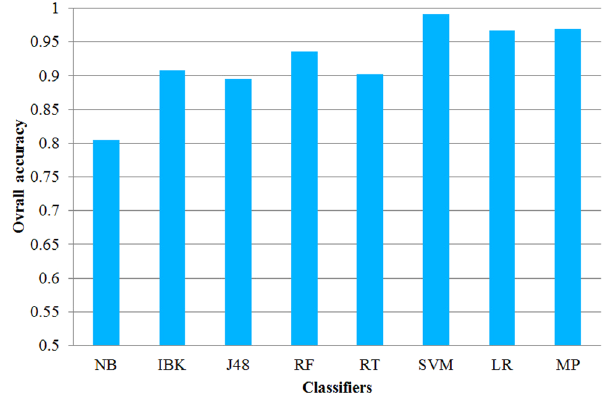
Figure 4. The comparison results of support vector machine (SVM), logisitic regression (LR), and multilayer perceptron (MP) with the naïve bayes (NB), IBK, J48, random forest (RF) and random tree